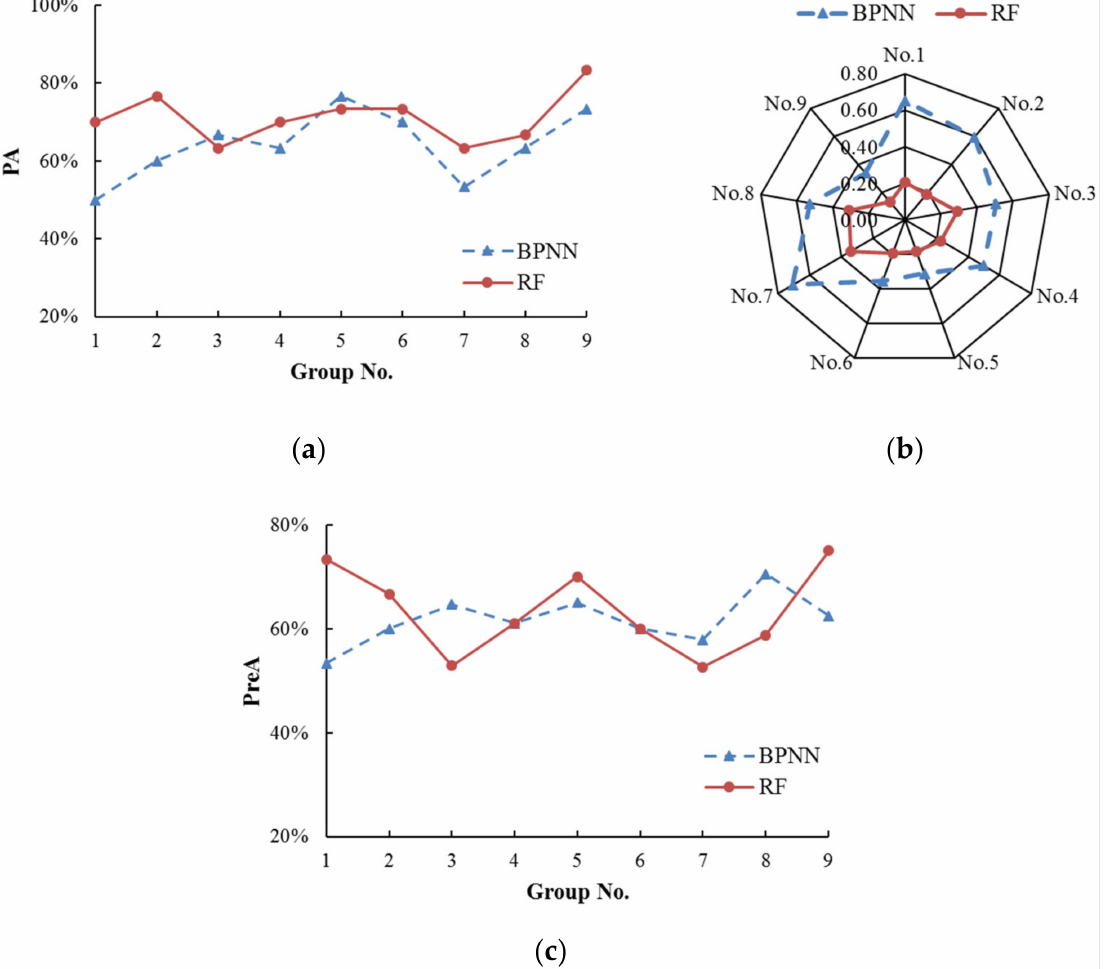
Figure 7. Index results of the No. 2 student in the second experiment: ( a ) PA; ( b ) MSE; ( c )